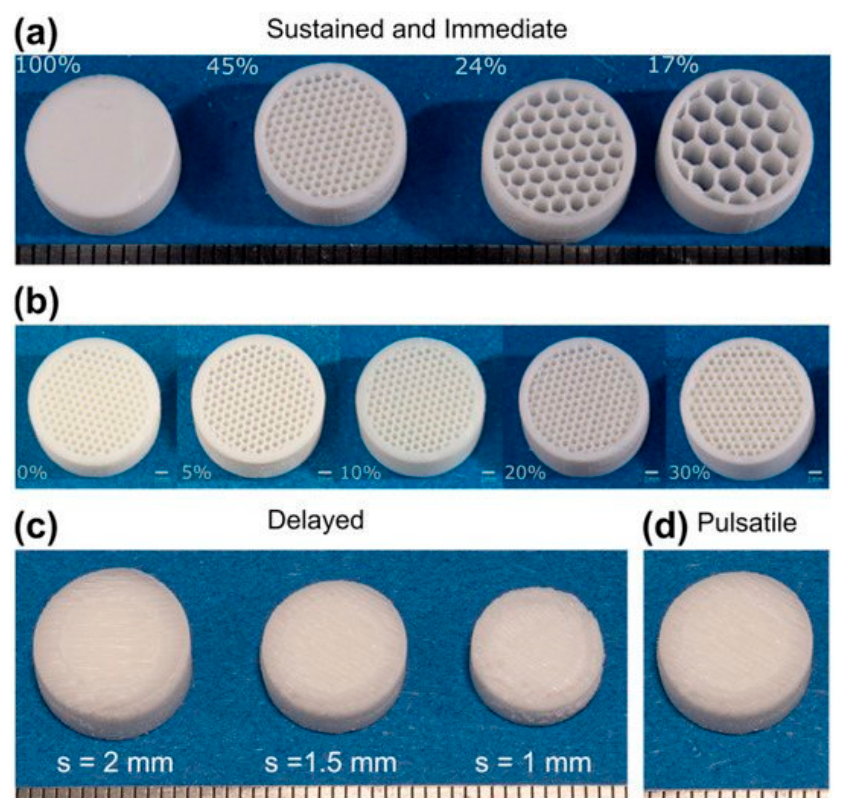
Figure 13. Images of sustained- and immediate-release tablets ( a ) with constant drug content (10% drug loading) and varying infill and ( b ) with varying drug content (5–30% drug loading) and constant infill (45%). ( c ) Delayed-release tablet with 1, 1.5 and 2 mm shell thickness (10% drug loaded core), and ( d ) pulsatile-release tablets. Ruler unit: 1 mm [160].